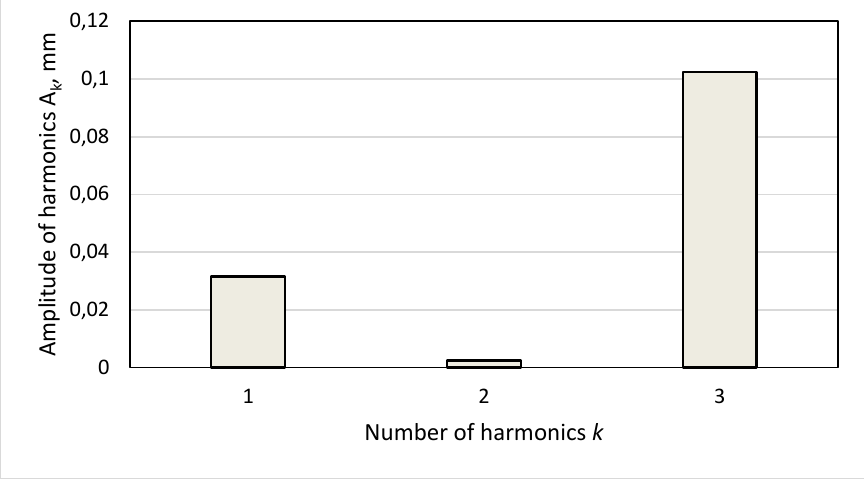
Fig. 6. The amplitude of harmonics of the thickness variation of the workpiece after harmonic